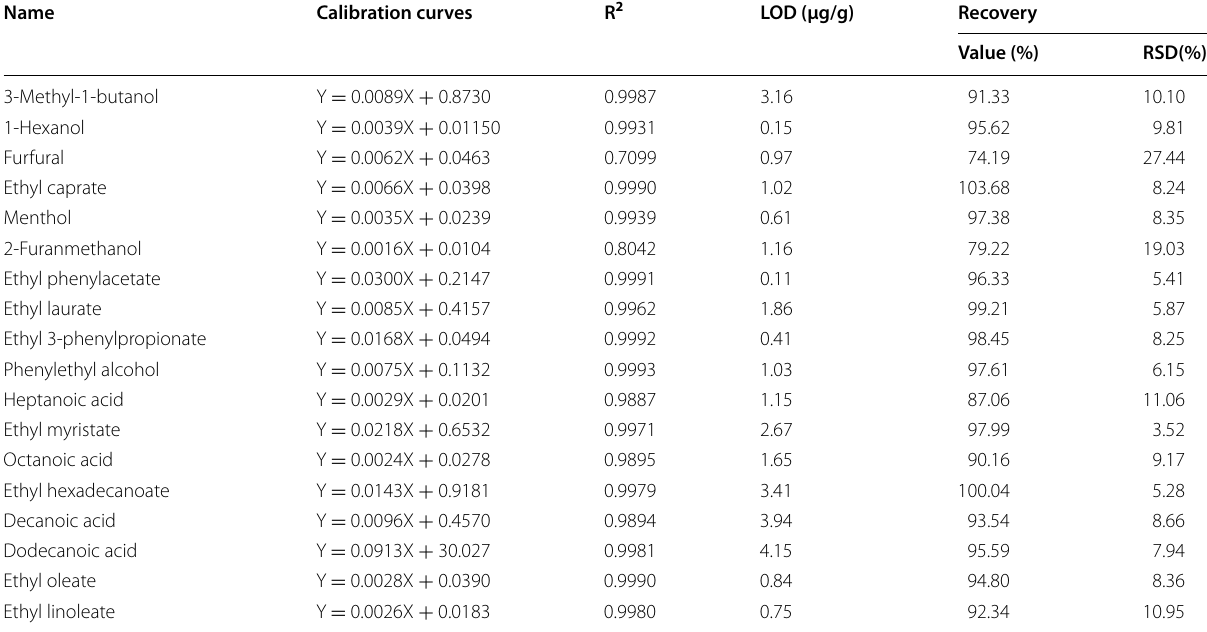
Table 2 Calibration curves of 18 target